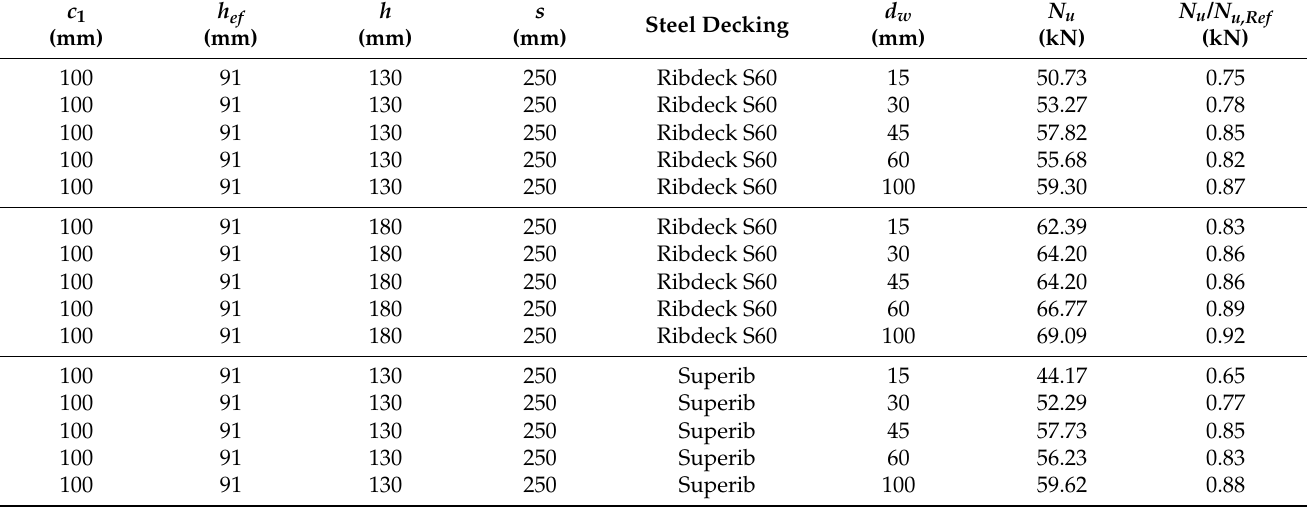
Table A2. Numerical results—Series 1 ( f c = 20 N/mm 2